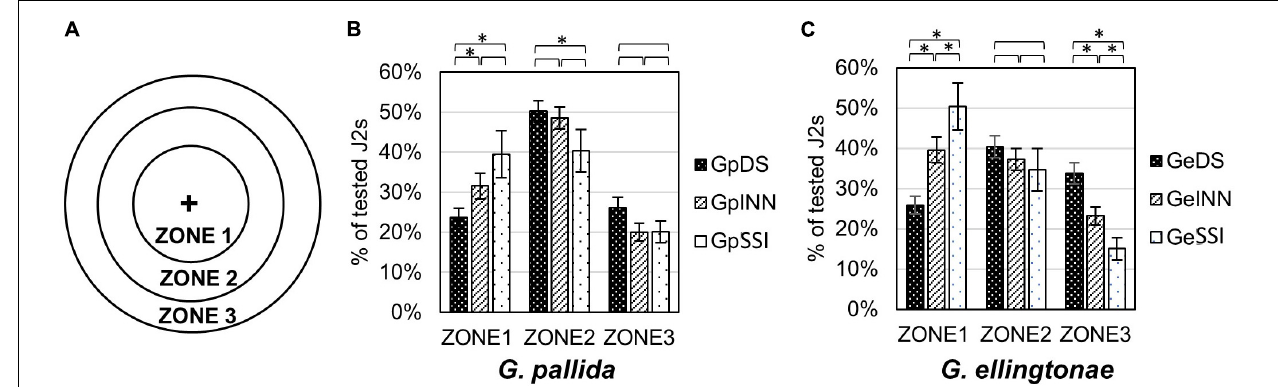
FIGURE 4 | Motility assessment for (B) Globodera pallida or (C) Globodera ellingtonae J2s hatched in root exudates from susceptible potato control (cv. Desirée - DS), resistant potato (cv. Innovator - INN), or immune plant ( S. sisymbriifolium - SSI). (A) Graph shows designated zones 1, 2, and 3 in a Petri dish (diameter 1, 3, and 5 cm, respectively). (B,C) Numbers represent the percentage of J2s in each zone recorded 90 min after dispensing the desired number of J2s in the middle of a Petri dish plate (“+”). Each value represents the mean ± SE from bulking samples of three independent experiments. Asterisk mark represents significantly different results as determined using ANOVA followed by Tukey’s HSD test at p < 0.05.